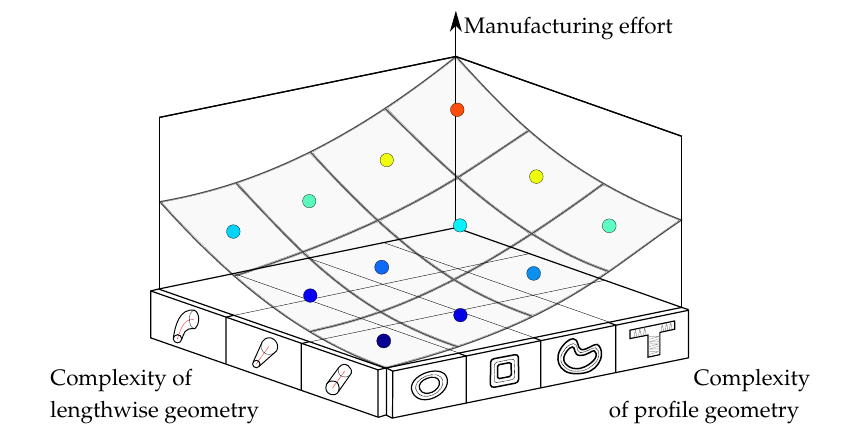
Figure 6. Manufacturing effort over complexity of profile and lengthwise geometry [1].